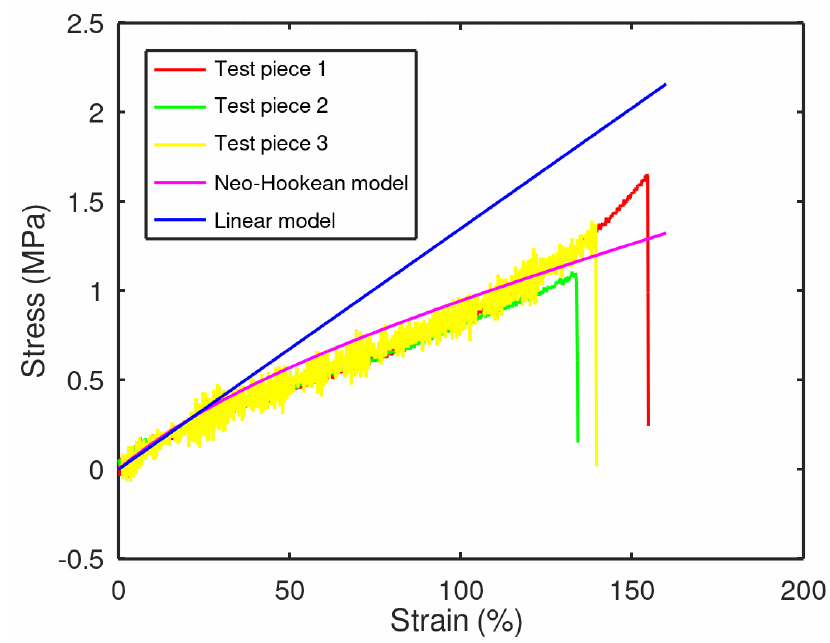
Figure 13. Conformal coating B tensile profile.